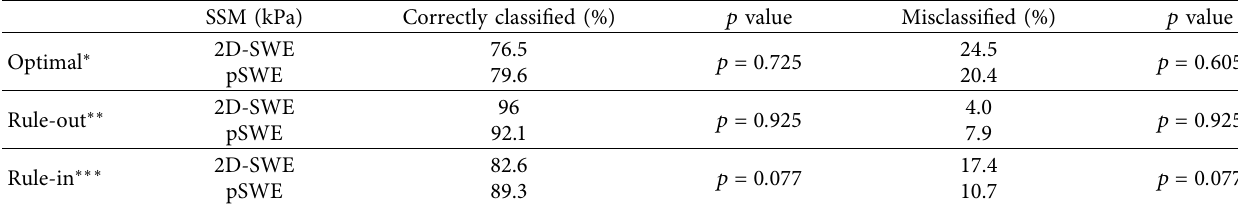
SSM: spleen stiffness measurements; Se: sensitivity; Sp: specificity; PPV: positive predictive value; NPV: negative predictive value; and AUROC: area under a receiver operating curve. ∗ Cut-off values with the higher sum of sensitivity and specificity were chosen. ∗∗ Cut-off values that optimized sensitivity were chosen. Cut-off values that optimized specificity were